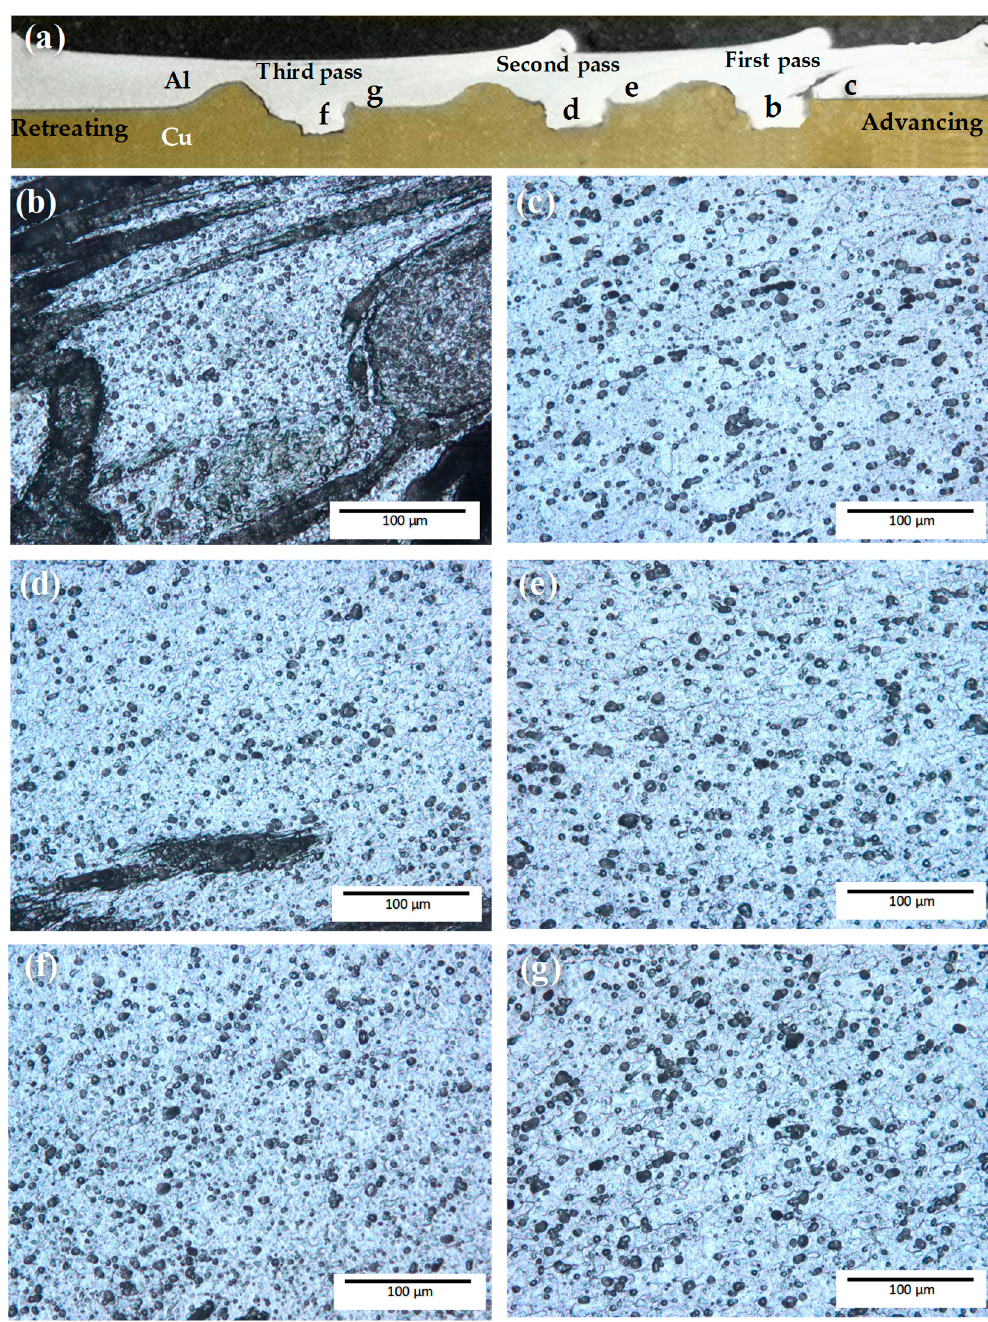
Figure 13. Microstructural morphology of Al alloy after joining; ( a ) macrostructure of friction stir cladded sample at the condition of 1055 r/min, 9 mm/min, and 50% overlap; ( b ), ( d ) and ( f ) SZ of the first, second and third passes, respectively, ( c ), ( e ) and ( g ) TMAZ/HAZ of advancing side for the first, second and third passes, respectively.